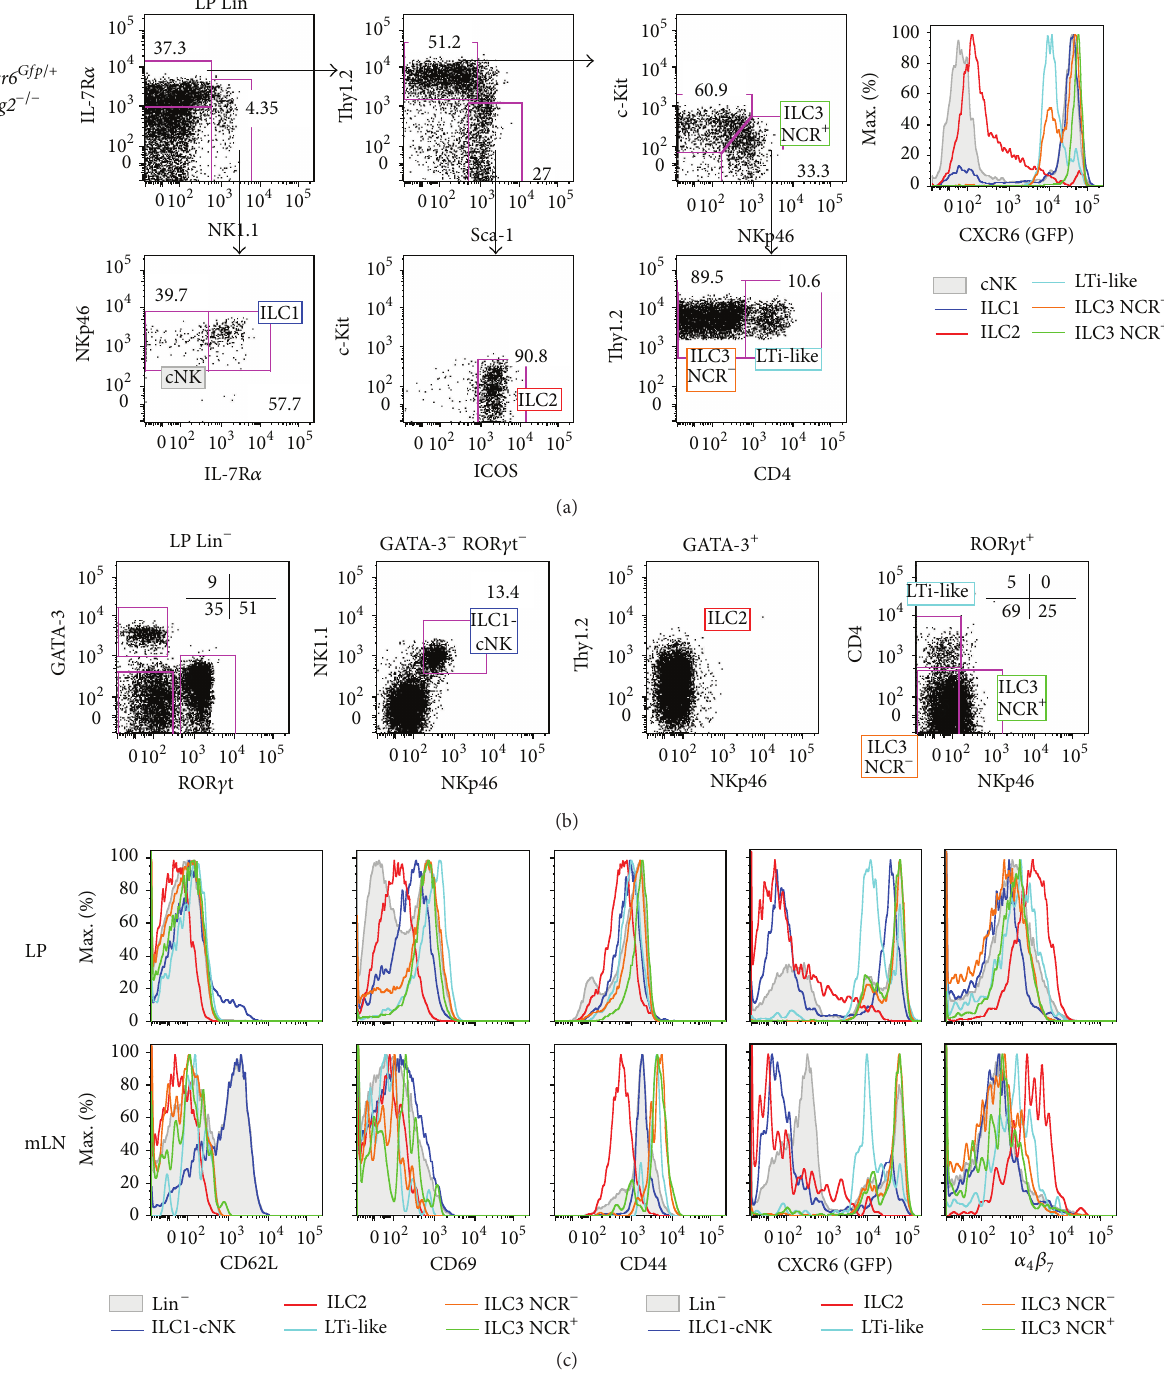
Figure 4: Intestinal ILC compartments have heterogeneous expression of CXCR6 and egress markers. (a) Flow cytometry of Lin −